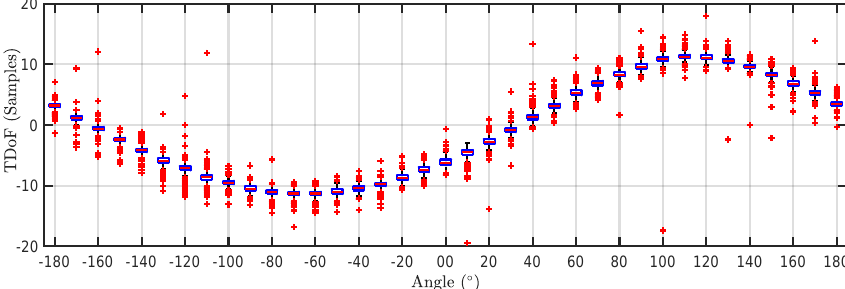
Figure 4. Box plot of the time differences of arrival versus angle of rotation for the pulses generated by the pulsed source.